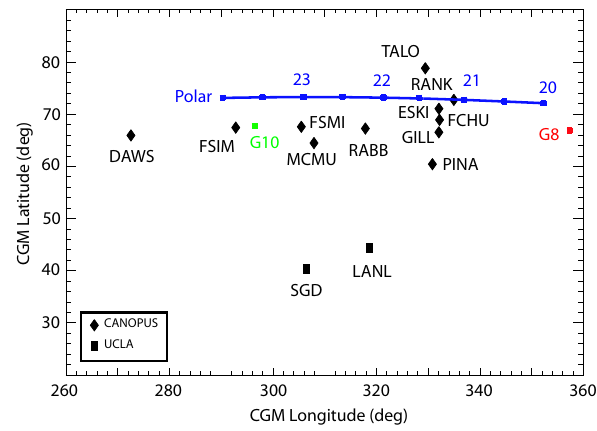
Fig. 9. The ground stations and spacecraft footprints in the North American sector in the Corrected GeoMagnetic (CGM)